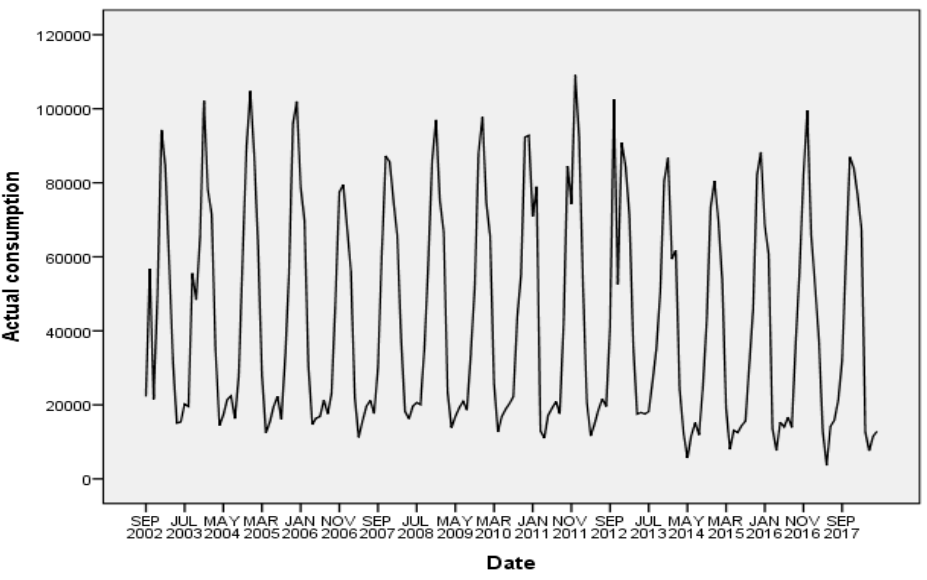
Figure 2. Time series of actual consumption for Best Practice 2 (BP2).